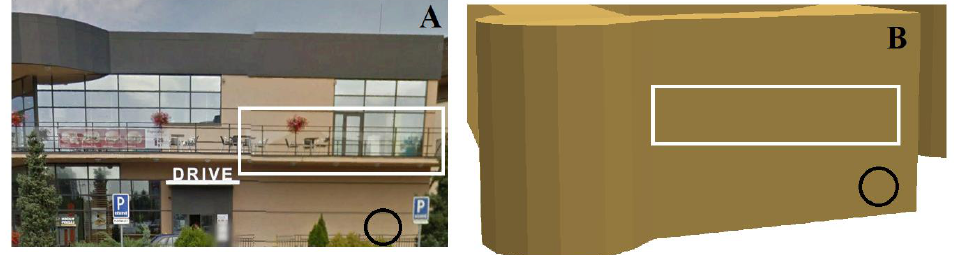
Figure 9. Location of the terrace on the Municipal Swimming Pool building: ( A ) real state of the building with terrace (white rectangle); ( B ) geometric 3D model, missing the terrace (white rectangle). The black circle represents themeasurement location. Table 5. Solar irradiance at Greek-Catholic Church in W/m 2 on 23 June 2021. Time Pyranometer